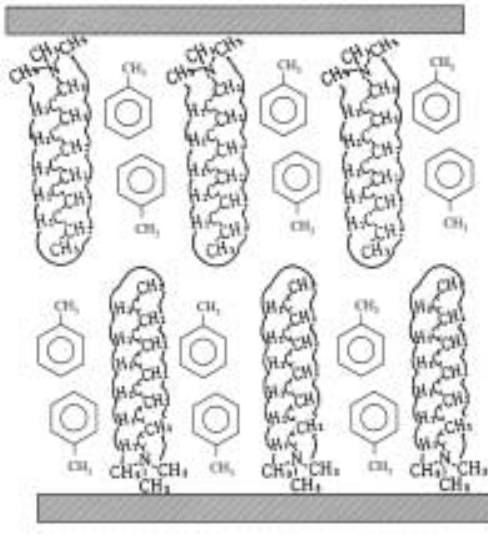
Fig. 4 Swelling model of toluene to montmorillonite intercalated by trimetyldodecylammonium cations. (modified from Fukushima